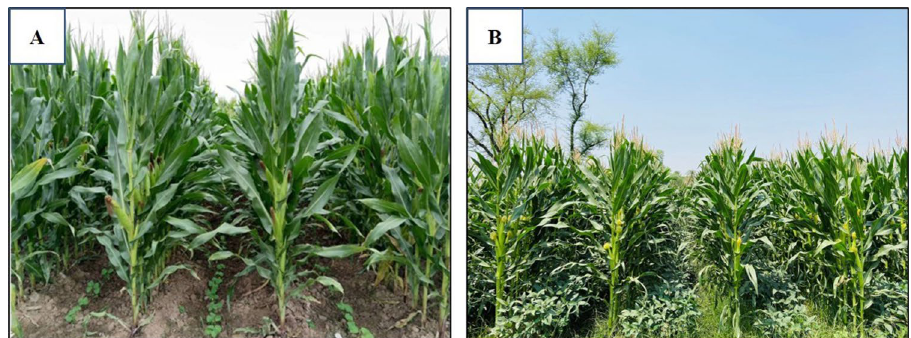
Figure 1. Example of traditional intercropping systems. ( A ) maize soybean relay-intercropping system (Photo: Muhammad Ali Raza, location: Sichuan province, China); ( B ) maize soybean intercropping systems